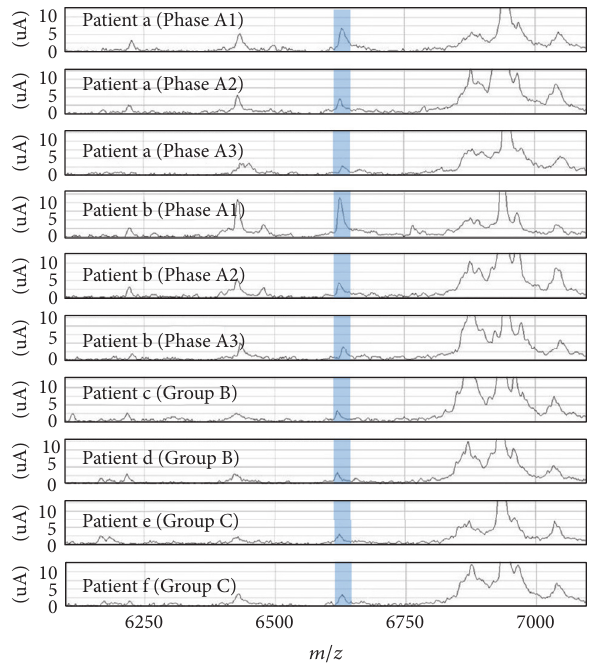
Figure 1: Representative spectra of six patients for the mass-to- charge ratio ( m/z ) of 6,626 (Q10, pH 5.0). The gray zone represents peaks at m/z 6,626. The upper six lanes show the serial change from Phase A1 to Phase A3 in patients a and b. The lower four lanes show the spectra of four patients from the control